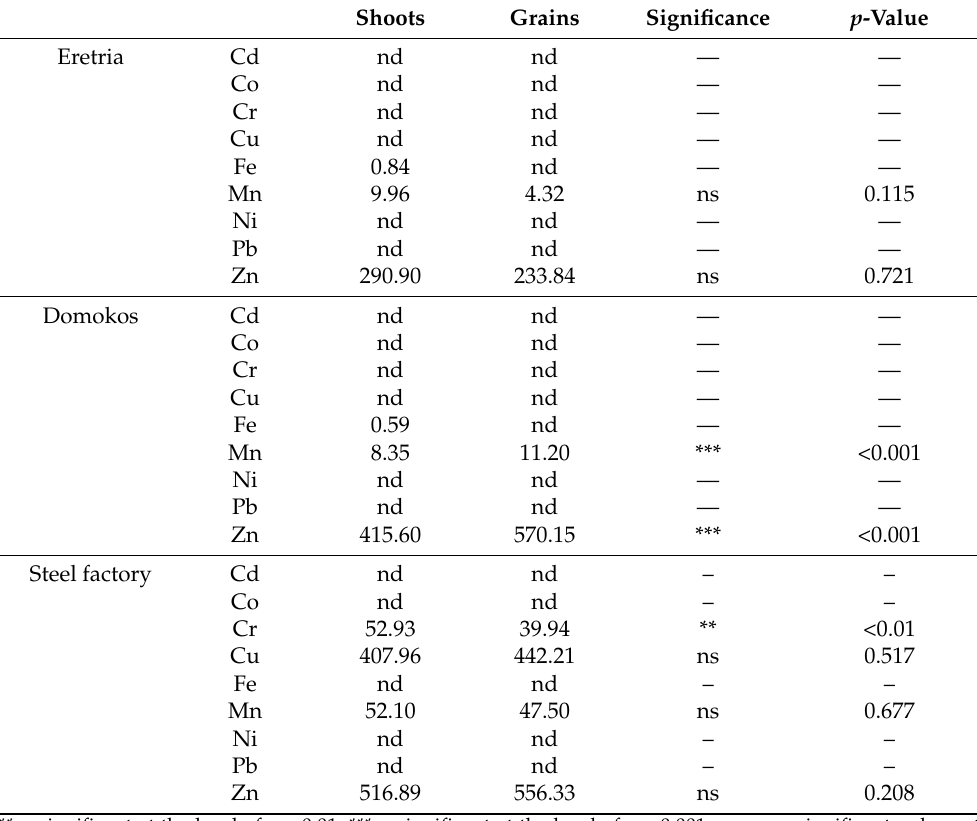
Table 3. Transfer coefficients (concentration in plant tissues over total concentration in soil) of potentially toxic elements in Eretria, Domokos and the steel factory—industrial area of Volos. Values are reported magnified by a factor of 10 3 for clarity. The comparisons are made among elements for each plant part (grains and shoots), and between plant parts for each element. Different letters within columns denote significance for each element at p < 0.05. Shoots